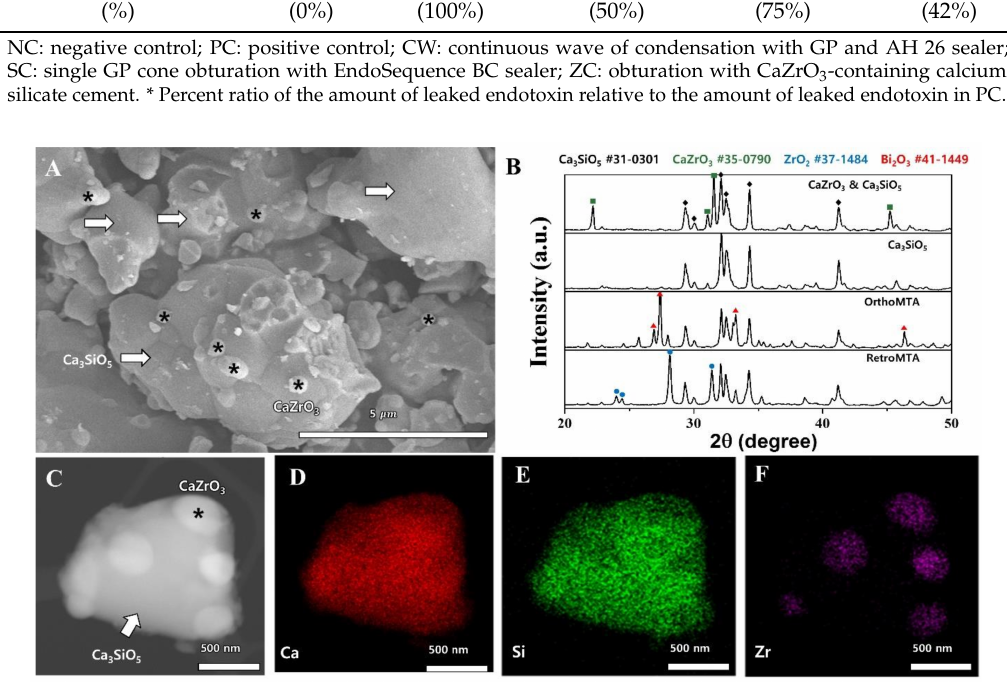
Figure 1. Phase analysis of CaZrO 3 -containing calcium silicate cement. ( A ) FE-SEM image of the synthesized CaZrO 3 -containing calcium silicate cement ( × 10,000); calcium zirconate (*) was generated, scattered around the tricalcium silicate facet (arrows). ( B ) X-ray diffraction pattern of the synthesized cement, tricalcium silicate without ZrO 2 , OrthoMTA and RetroMTA. The elemental analysis showed the presence of tricalcium silicate (Ca 3 SiO 5 ) and calcium zirconate (CaZrO 3 ) in the synthesized cement. Bismuth oxide (Bi 2 O 3 ) and zirconium oxide (ZrO 2 ), which are components of OrthoMTA and cement; in which, calcium zirconate (*) and tricalcium silicate (arrow) were observed. ( D – F )